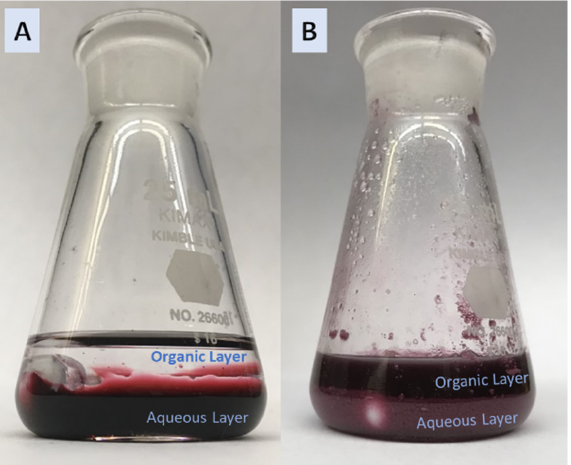
Figure 2. Images of the reaction mixture, ( A ) before reaction has started and ( B ) after completion of the phase transfer with n-butylsilane.